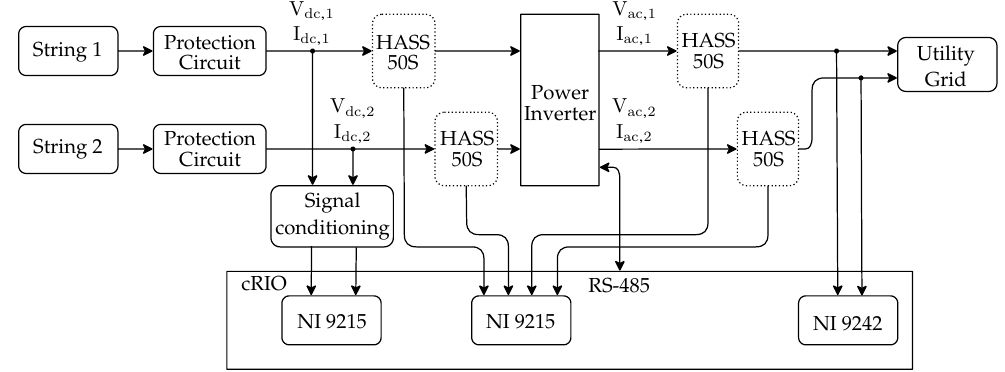
1 − α n cha ⌋ channel uses. ( )